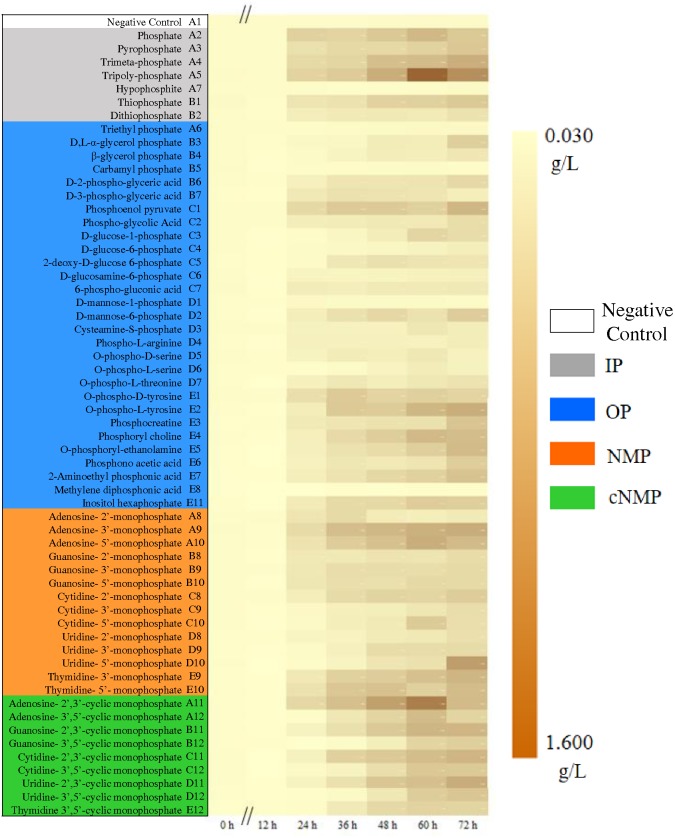
Growth dynamics of the activated sludge cultivated with different phosphorus sources. Phosphorus sources with different background color refer to different groups: Gray for IP, blue for OP, brown for NMP, green for cNMP, and white for negative control. MLSS increases from 0.030 g/L (yellow) to 1.600 g/L (brown).